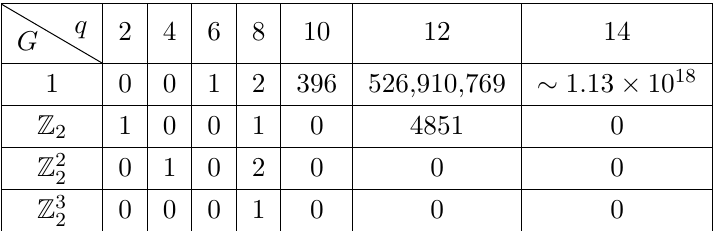
Table 1. The number of isomorphism classes of one-factorizations of K q with given symmetry group G = Aut( F ). The values for q = 12 and 14 were determined using [18] and [19], respectively; the exact count for q = 14 is quoted in the main